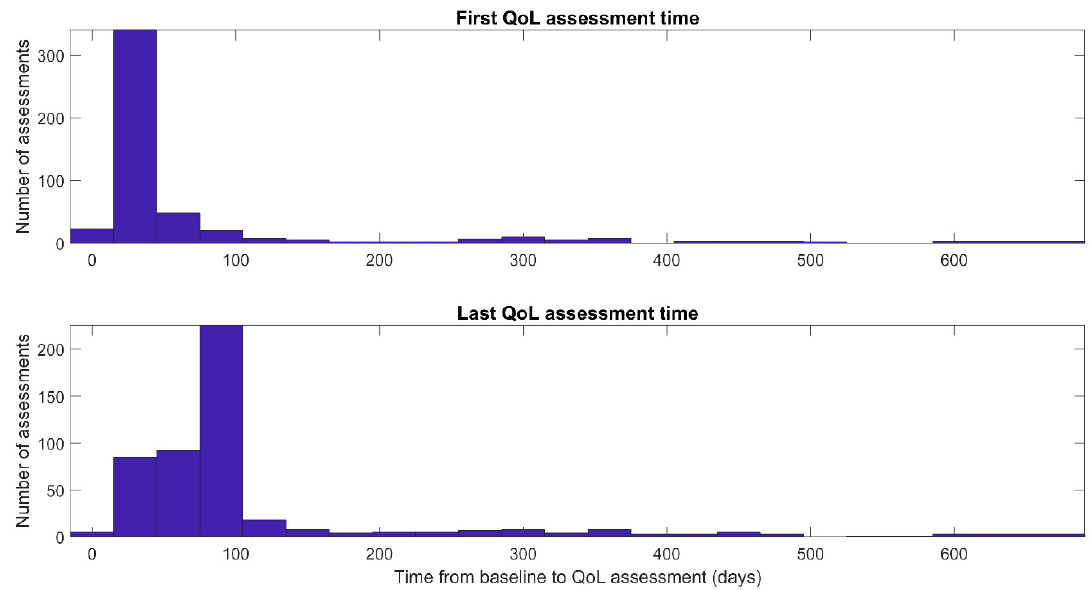
Figure 2. Histogram of the first ( Top ) and last ( Bottom ) time for QoL assessment in days from baseline. The baseline QoL scores were 58 ± 24.5 (Figure 3).